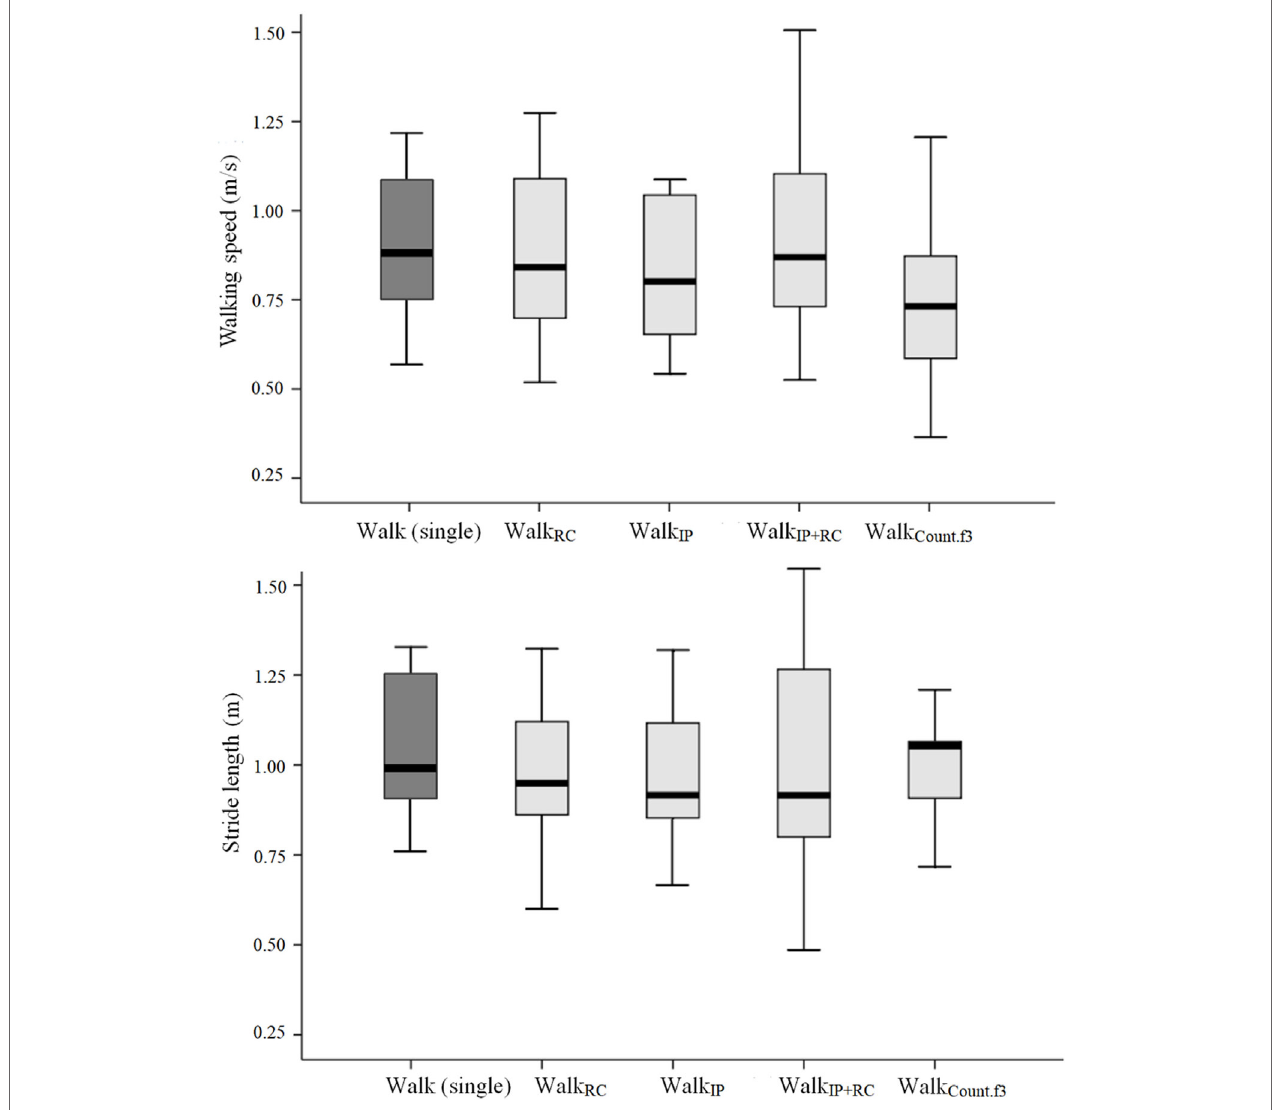
FigUre 1 | Gait parameters measured during each task condition. Top panel presents the walking speed and bottom panel presents the stride